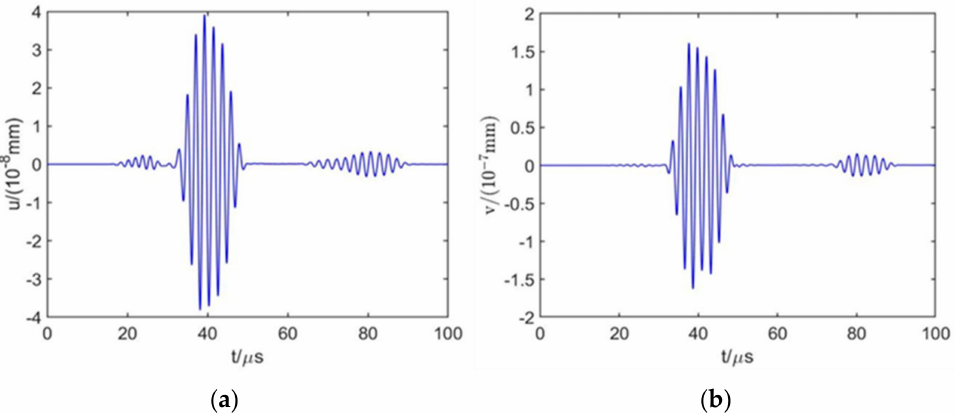
Figure 4. Surface wave displacements at point P. ( a ) In-plane displacement; ( b ) out-of-plane